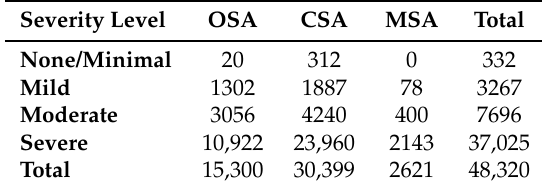
Table 1. Distribution of Number and Types of Apneic Events per each Class of the Severity